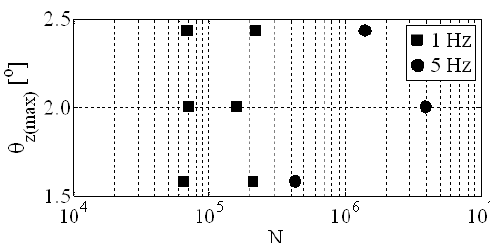
Figure 7. Maximum rotation angle against the number of cycles up to